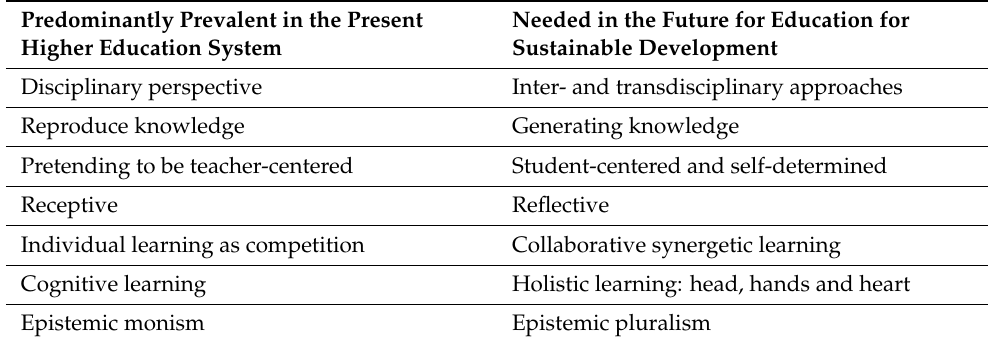
Table 1. This table shows the approaches to transformative pedagogy in the sense of the ESD criteria, (Education for Sustainable Development)